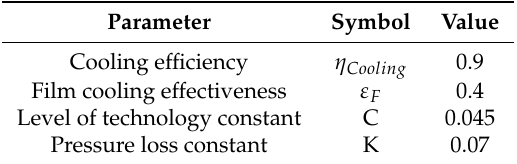
Table 1. Cooling system model parameters based on the model from